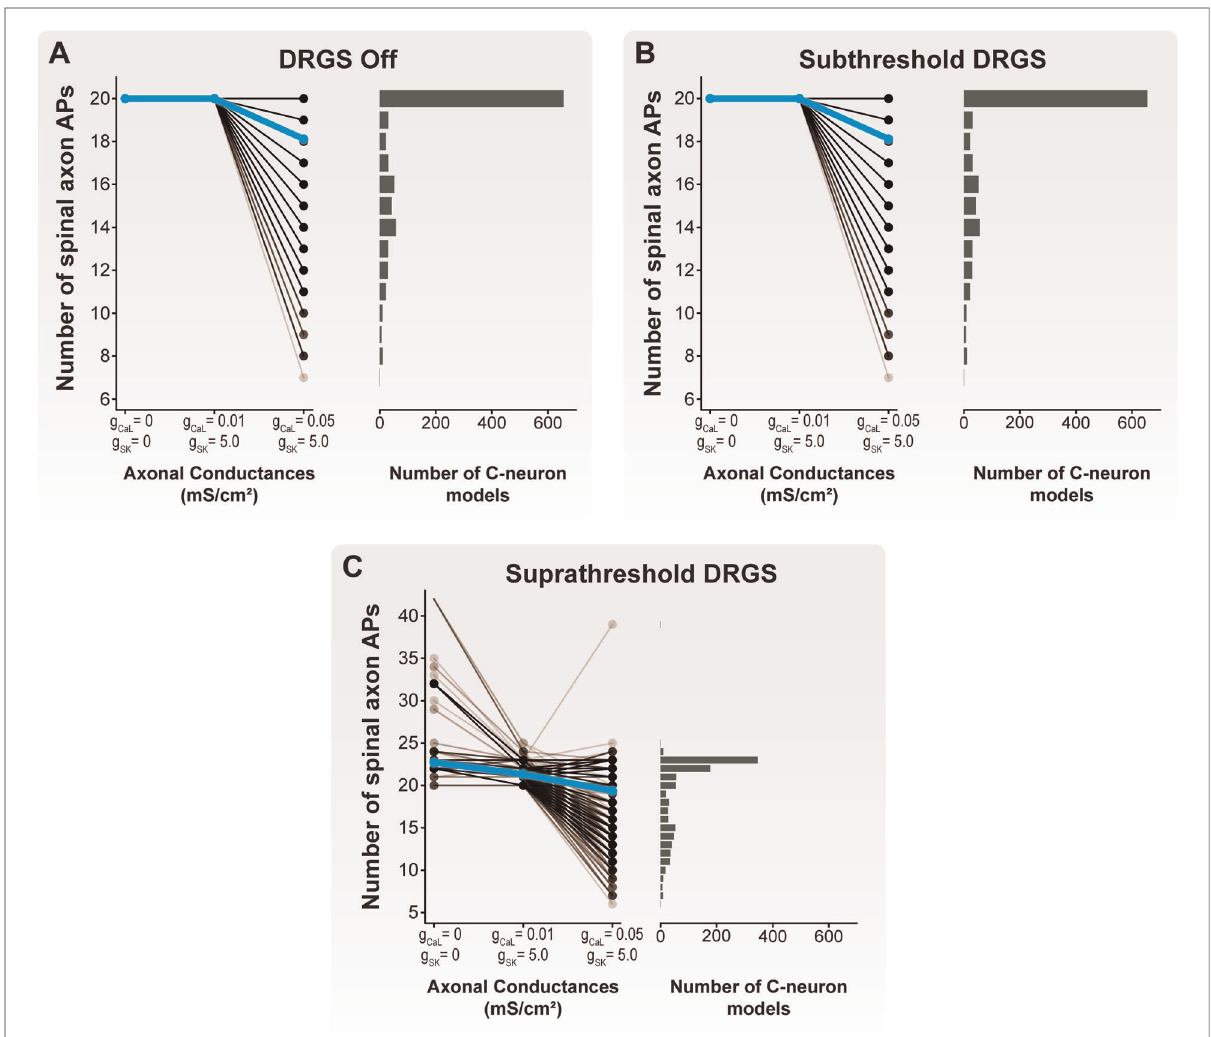
FIGURE 8 Effect of axonal Ca L and SK conductances on AP propagation through the T-junction during tonic DRGS. Each brown line corresponds to an individual model C-neuron, and each blue line corresponds to the model population average. Horizontal histograms share the y -axis of each corresponding line plot and indicate the number of model C-neurons with a given number of APs propagating into its spinal axon. When ( A ) DRGS was turned off or ( B ) applied at 1 mA, including axonal SK and Ca L conductances fi ltered some of the 20 APs propagating orthodromically through the T-junction. ( C ) When applying suprathreshold DRGS, some model C-neurons propagated more than the 20 peripherally generated APs into the spinal axon, while other model C-neurons fi ltered many of the APs generated in the periphery or by the DRGS